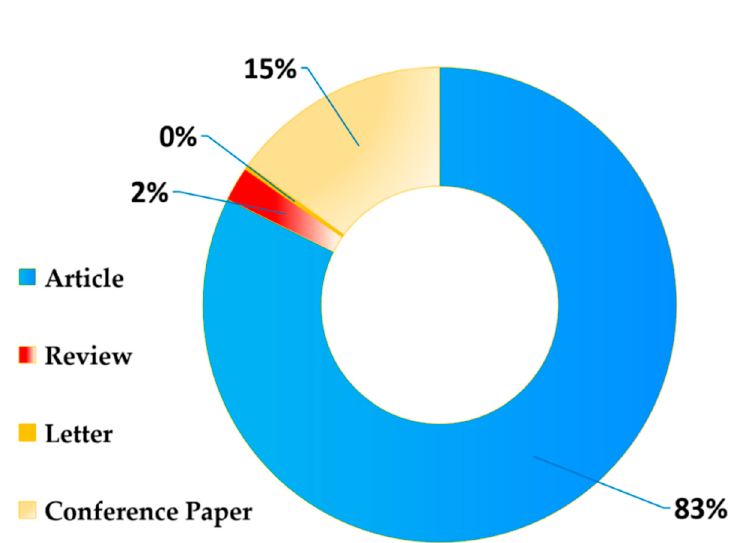
Figure 5. Post volume by